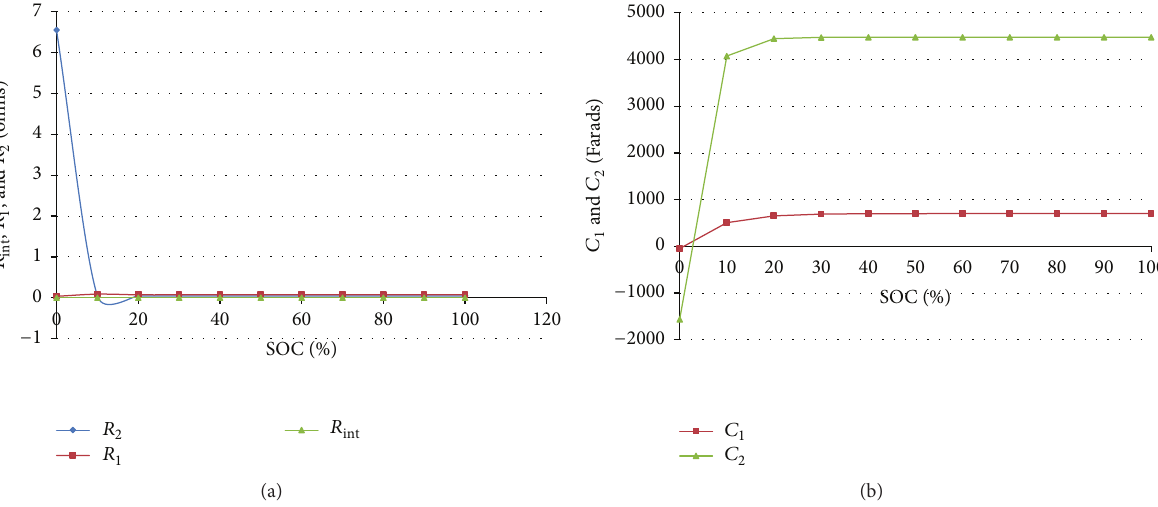
Figure 4: RC parameter variation with SOC (a) 𝑅 int , 𝑅 1 , and 𝑅 2 and (b) 𝐶 1 and 𝐶 2 .